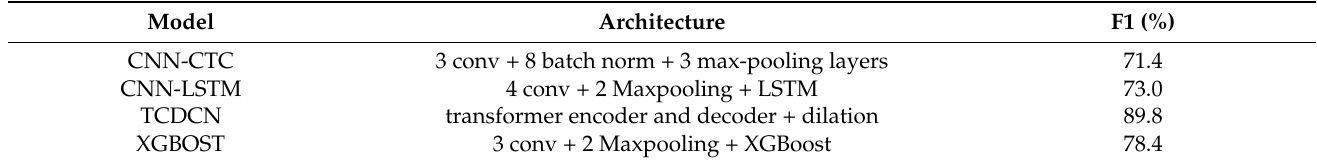
Table 3. Result of Accuracy VALUES on the test